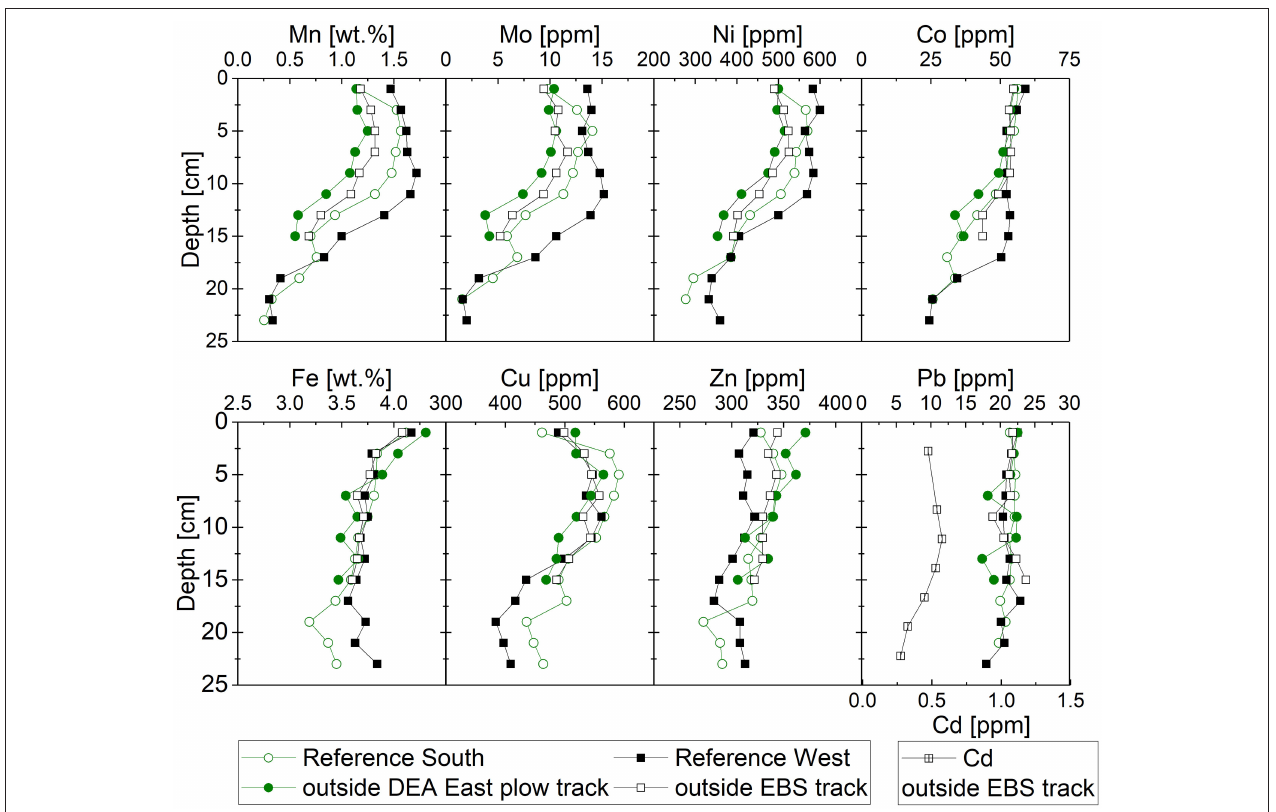
FIGURE 4 | Sediment element profiles of the four undisturbed sites. Reliable Cd results only for outside EBS